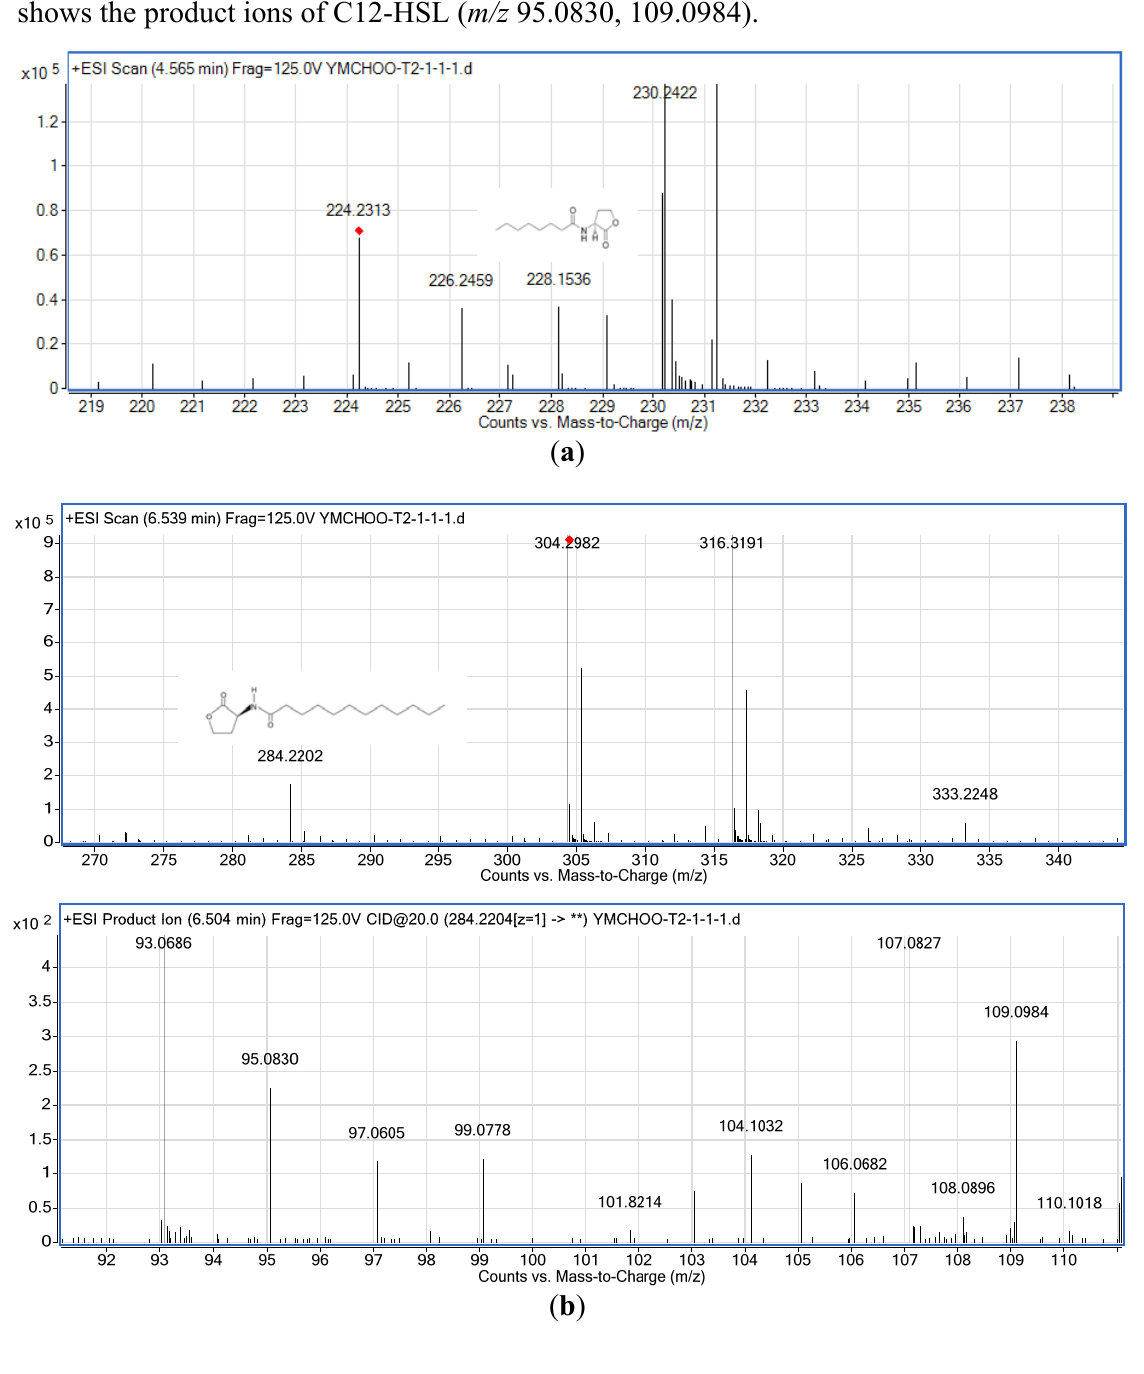
K. pneumoniae (T2-1-1). ( a ) Mass spectra of C8-HSL ( m/z 228.1536). ( b ) Mass spectra of C12-HSL: the upper panel shows the parent ion ( m/z 284.2202) while the lower